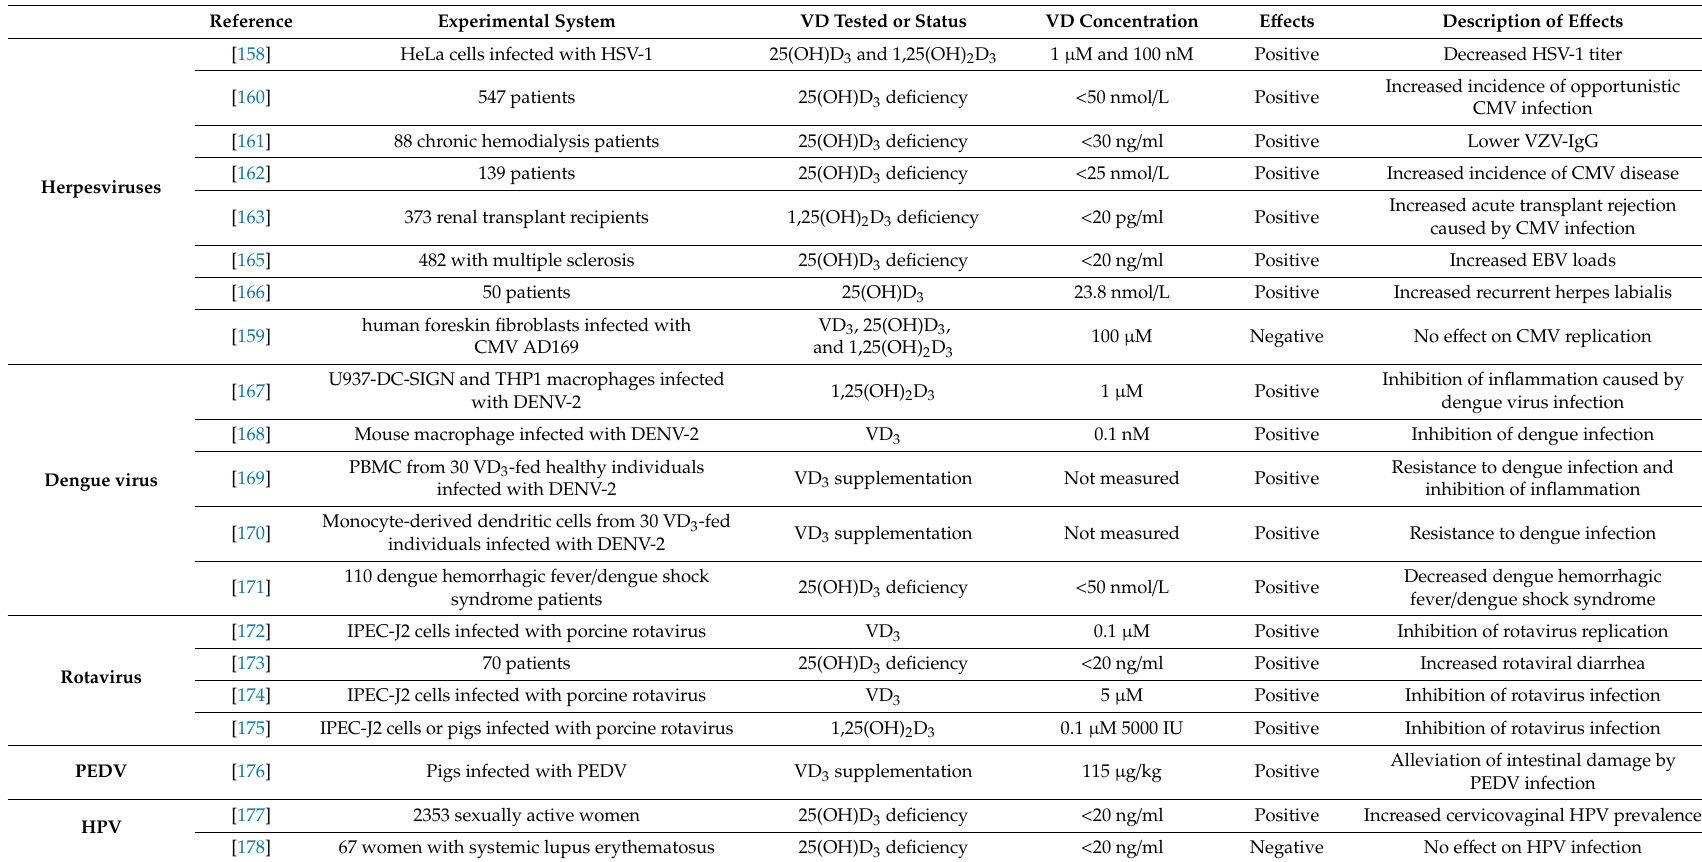
Table 5. E ff ects of VD on infection, pathogenesis, and treatment outcome by other